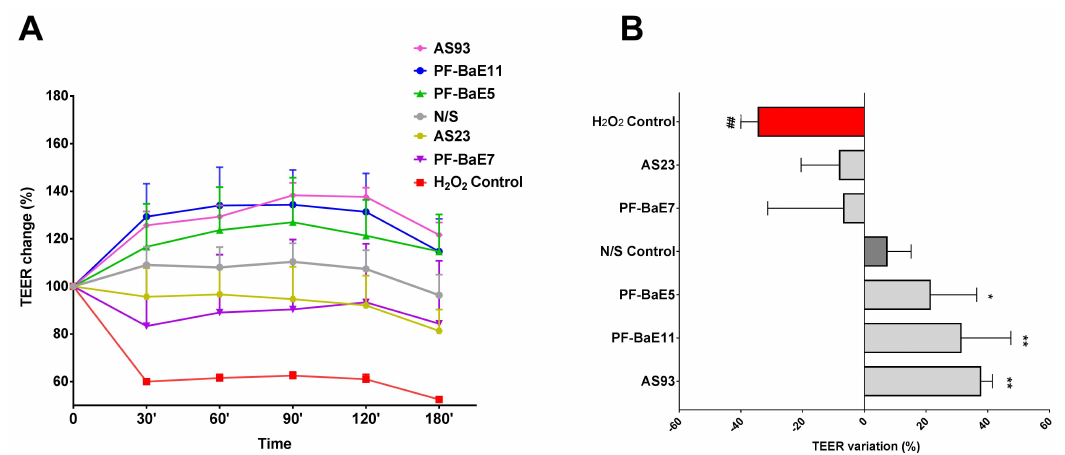
Figure 1. Ability of the strains to restore the H 2 O 2 -induced disruption of the epithelial barrier. The Caco-2 confluent monolayers were pre-treated (or not) with the bacteria at the apical side (10:1 bacteria / cell ratio) for 30 min and sensitized with H 2 O 2 (100 µ M). Trans-epithelial electrical resistance (TEER) was measured at T0 and every 30 min. Data represent ( A ) the time-dependent means of relative changes (in %) of TEER ± SEM in comparison to TEER at T0 and ( B ) the final % TEER variations at 120 min. # and * refer to the comparison of the cells treated with H 2 O 2 (H 2 O 2 Control) and without H 2 O 2 (N / S Control)